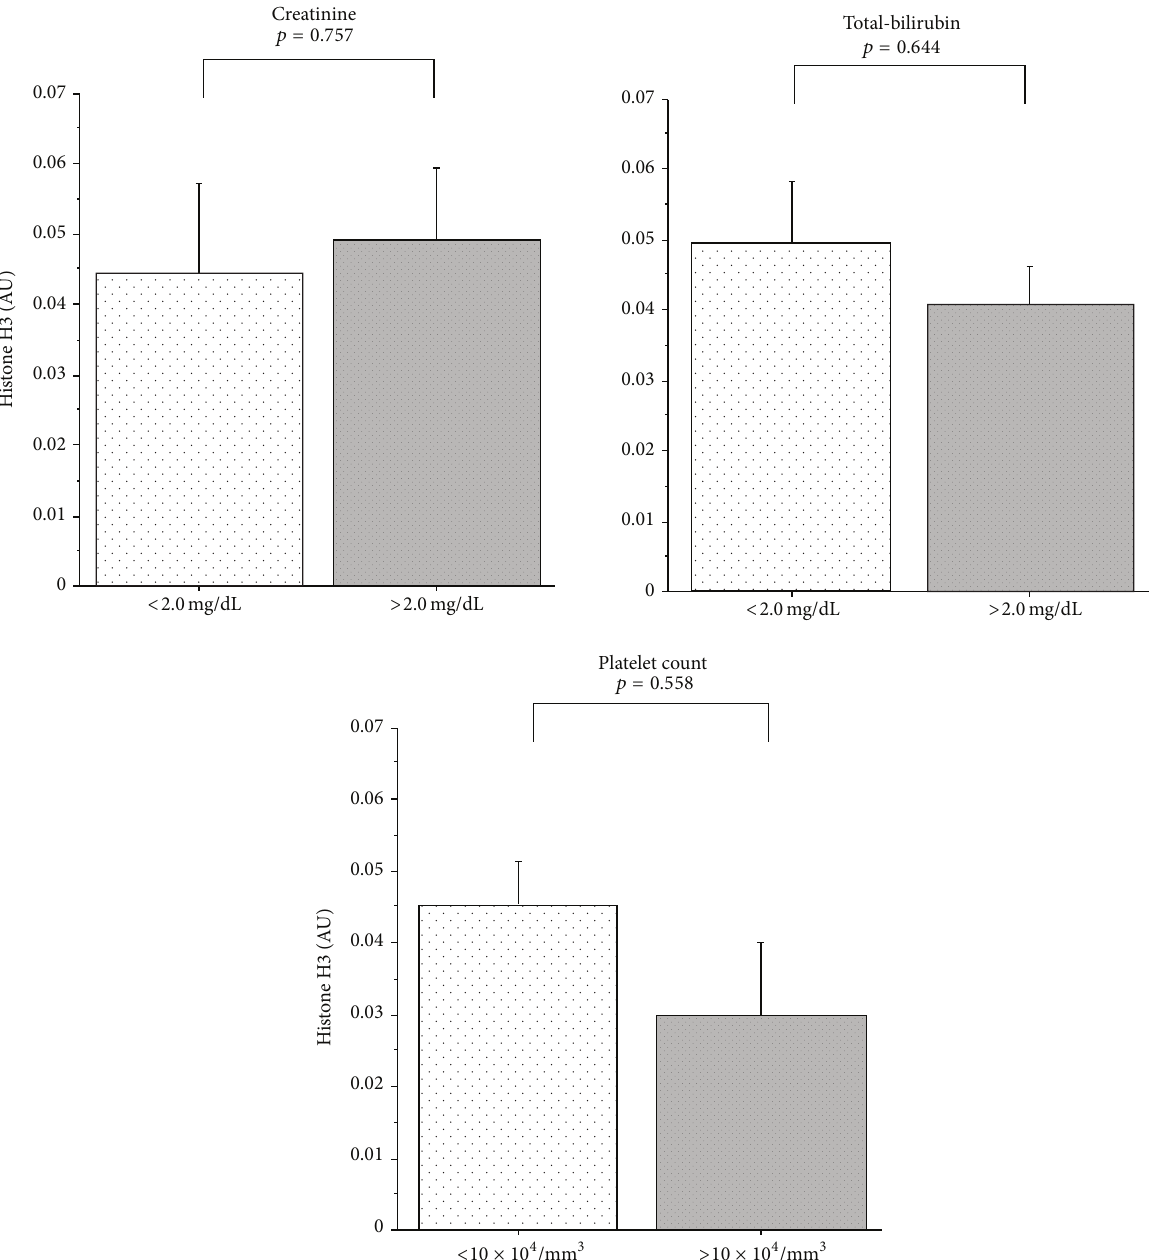
Figure 5: Comparison of histone H3 levels in patients with or without organ dysfunction. Circulating levels of histone H3 in patients with renal dysfunction (creatinine > 2.0 mg/dL), hepatic dysfunction (total-bilirubin > 2.0 mg/dL), and thrombocytopenia (platelet count < 10 × 10 4 /mm 3 ) are compared to those in the patients without organ dysfunction. Significant difference was not seen between patients with and without organ dysfunction. Data are expressed as mean ± standard error. AU: absorbance